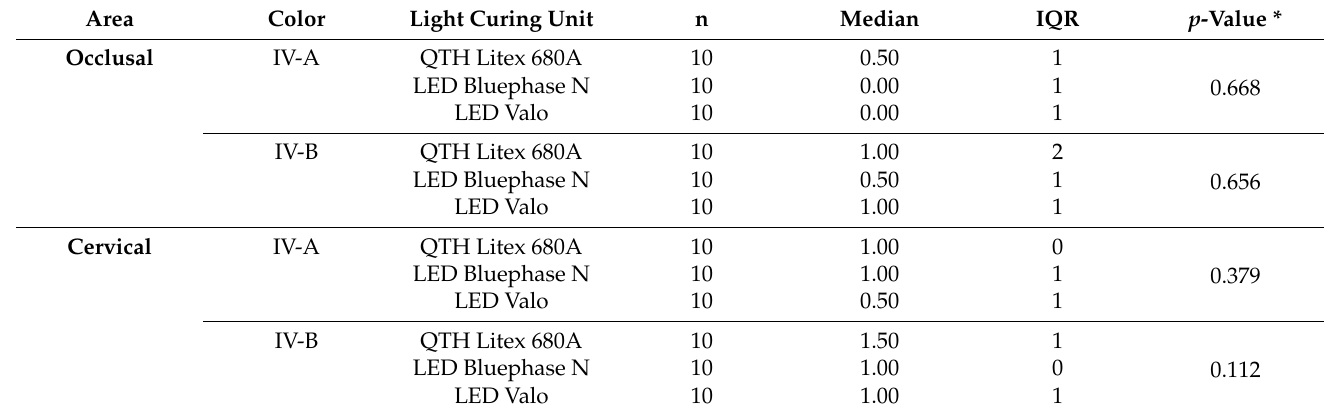
Table 3. Microleakage in occlusal and cervical areas of dental restorations with Tetric N-Ceram resin composite according to area.